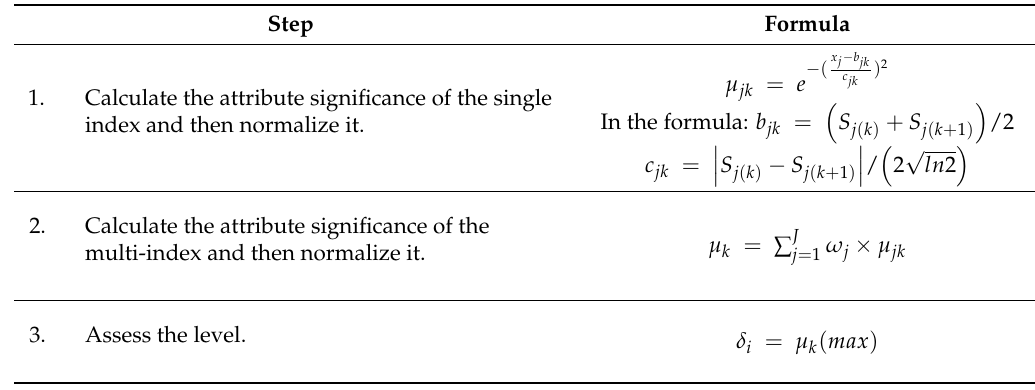
Table A4. The step and formula of AR.